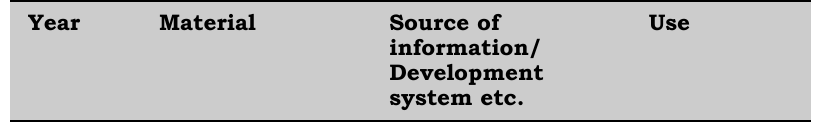
Table 1. Development history from crab shell to